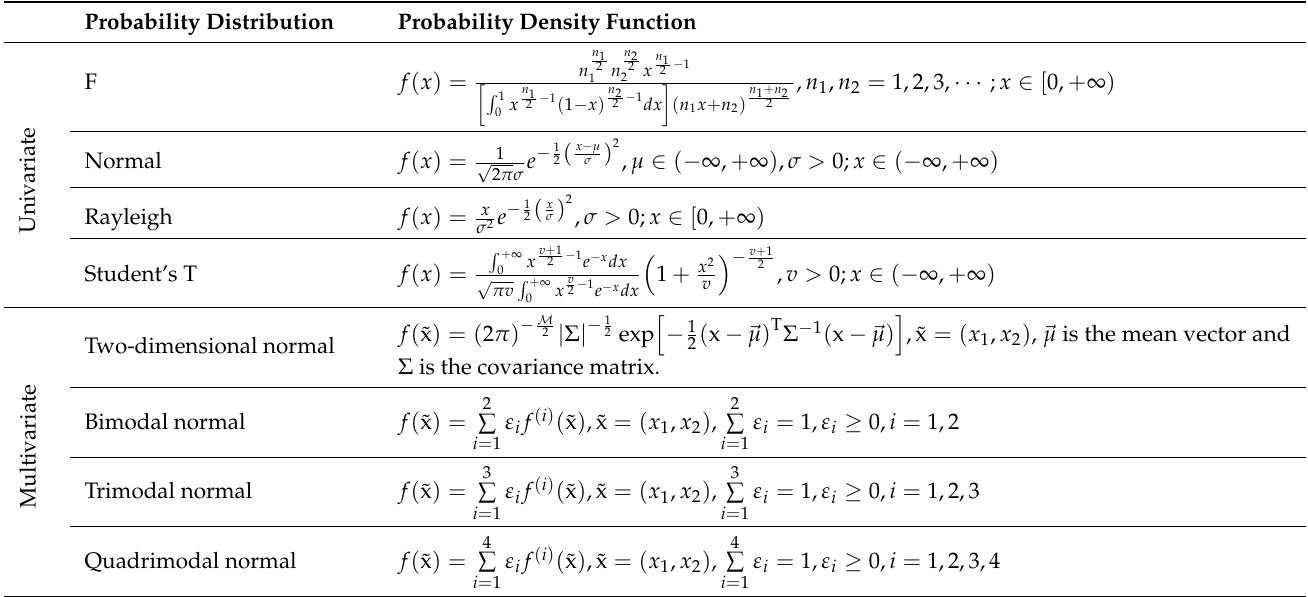
Table 1. Four univariate and four multivariate probability distributions ( f ( i ) ( ˜x ) in bimodal, trimodal, and quadrimodal normal distributions is the two-dimensional normal distribution with mean vector (cid:126) µ ( i ) and covariance matrix Σ ( i ) ). Probability